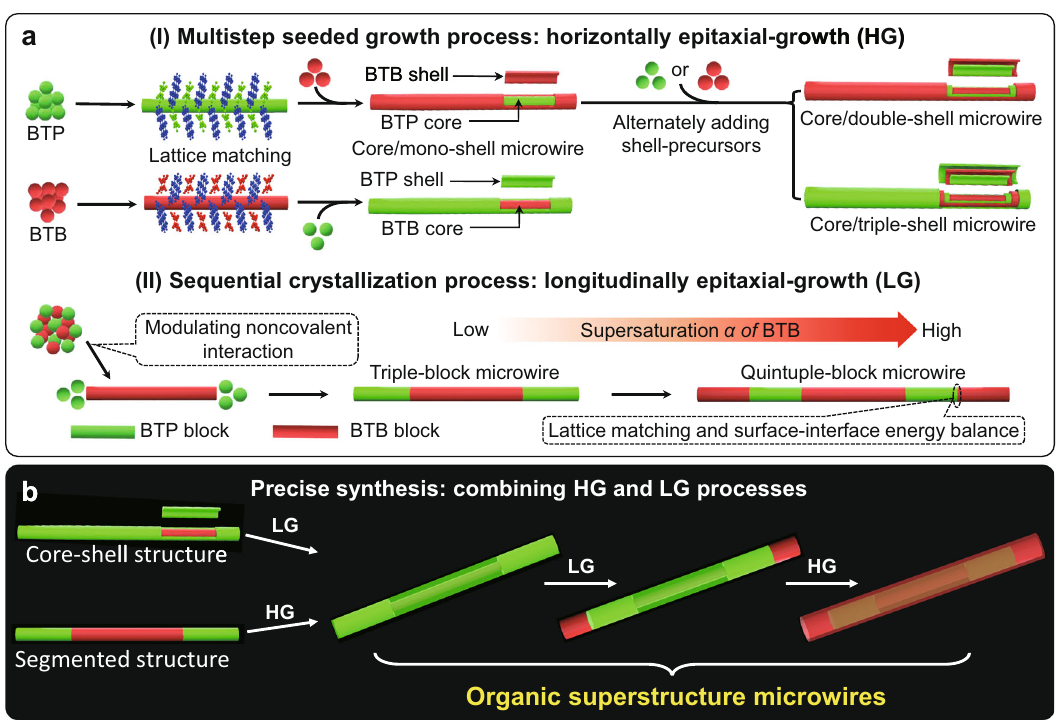
Fig. 1 Illustration of the epitaxial-growth for organic superstructure microwires. a Schematic illustrations: (I) the horizontal epitaxial-growth mode for the organic core/shell microwires via a multistep seeded growth process and (II) the longitudinal epitaxial-growth mode for the organic multiblock microwires via a sequential crystallisation process. The red-emissive and green-emissive cartoon spheres represent the BTB and BTP cocrystal, respectively. Their chemical structures were shown in Supplementary Fig.1. b Schematic illustration of the combination of the horizontal and longitudinal epitaxial-growth modes for the organic superstructure